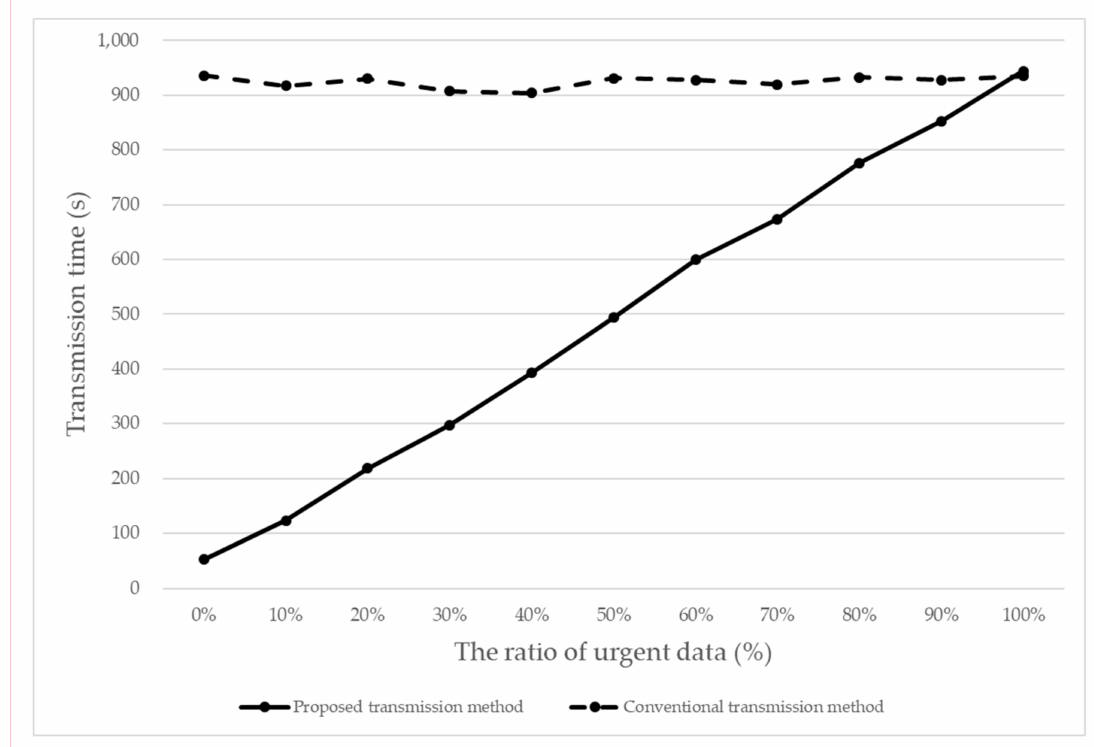
Figure 8. Performance comparisons between the proposed transmission method and the conventional transmission